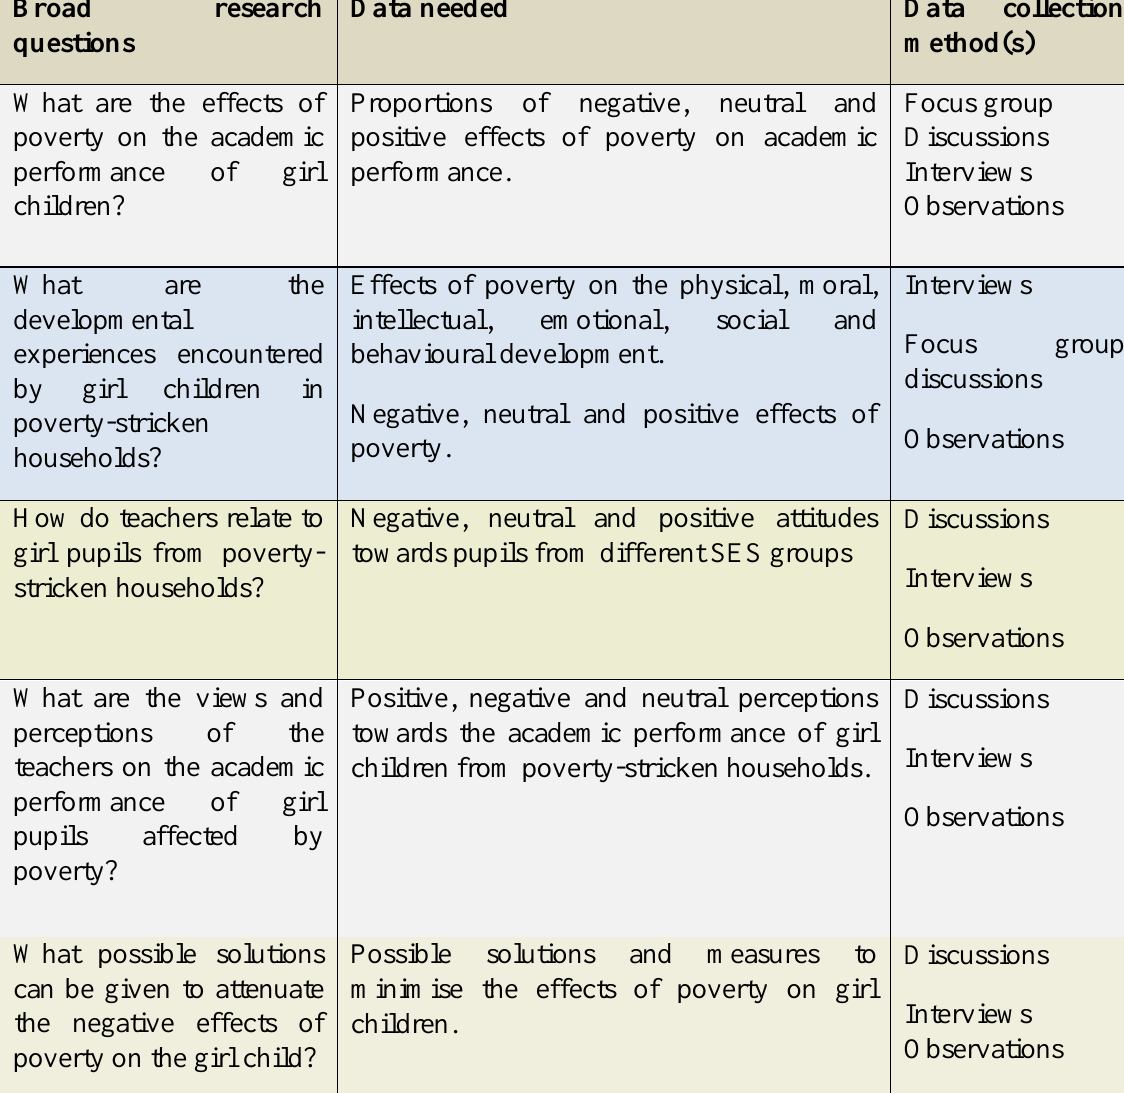
Table 4.2: The Data Matrix Plan